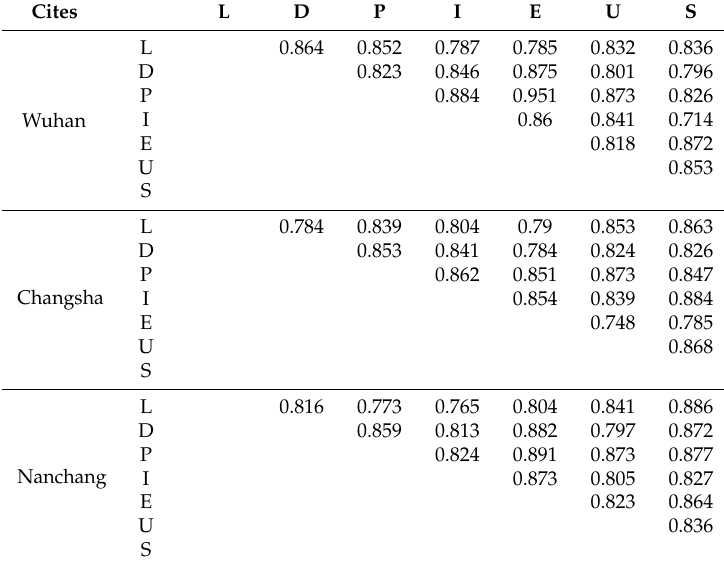
Table 4. Correlation between urbanization factors and NTL in three capital cities.